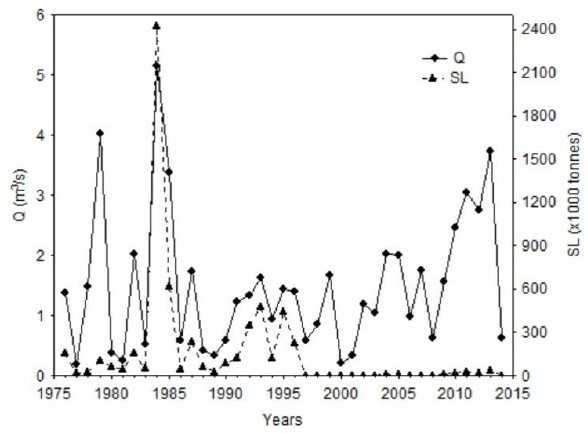
Figure 4: Variation of annual water discharge and sediment load in the study